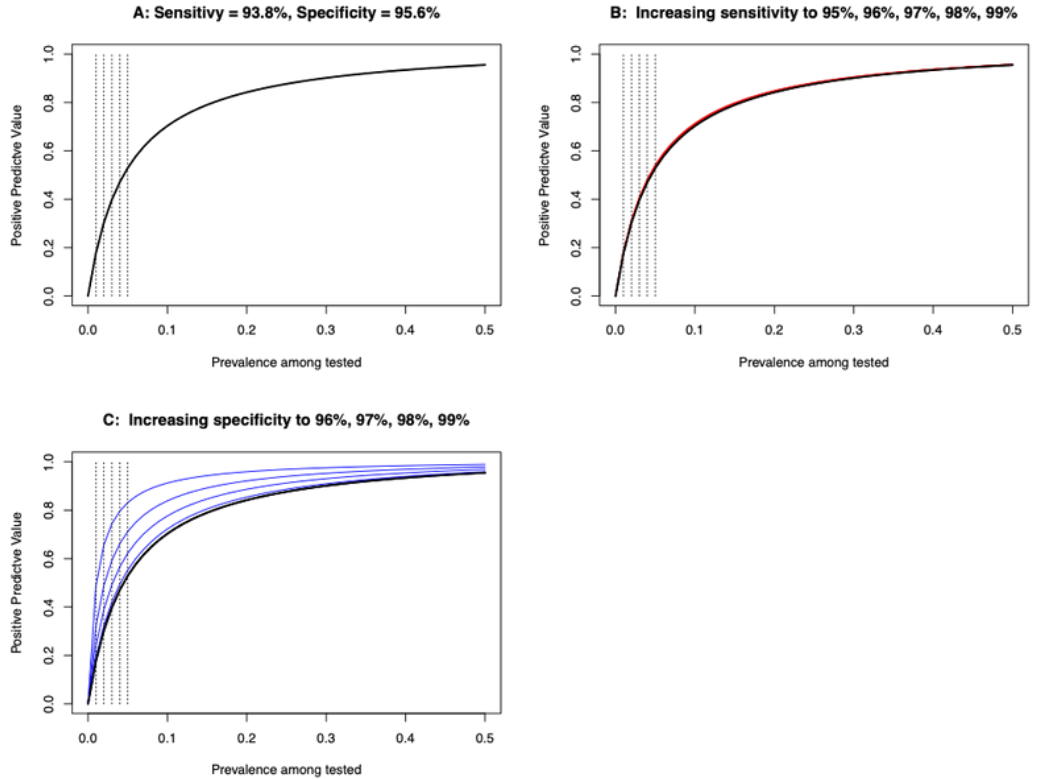
Figure 4. The relationship between the prevalence of antibodies among those tested and the positive predictive value. In (A), we see increasing positive predictive value with increasing prevalence (prevalence of 1% to 5% indicated by vertical dashed lines. In (B), we see the minimal impact of increasing sensitivity from 95% to 99% (red lines). In (C), we see the improvement in positive predictive value associated with increasing specificity from 96% to 99% (blue